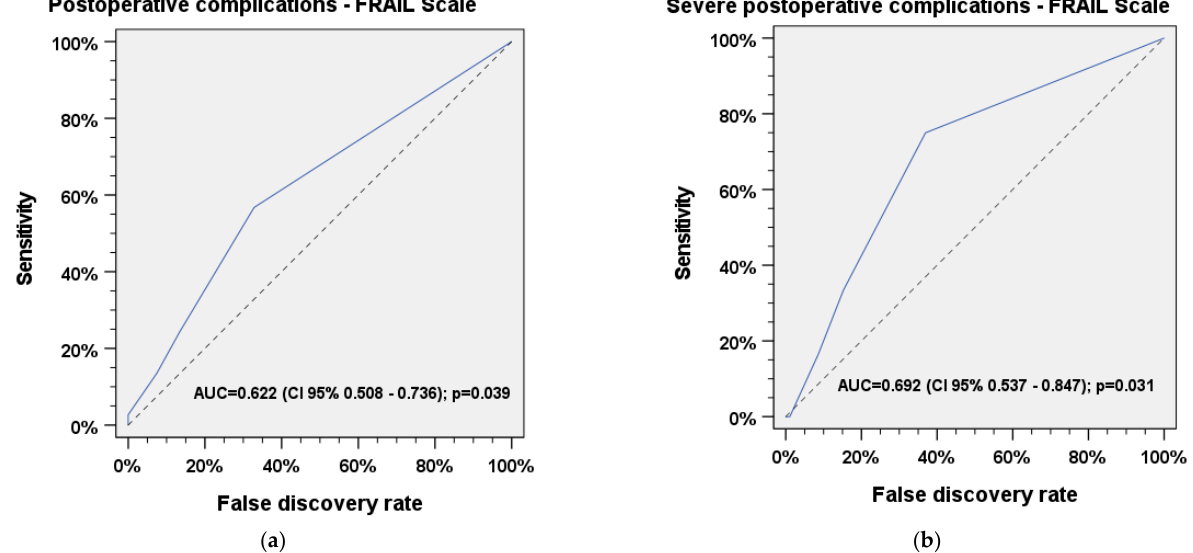
Figure 3. Receiver operater characteristic (ROC) analysis for ( a ) any and ( b ) severe postoperative complications vs. FRAIL Scale.